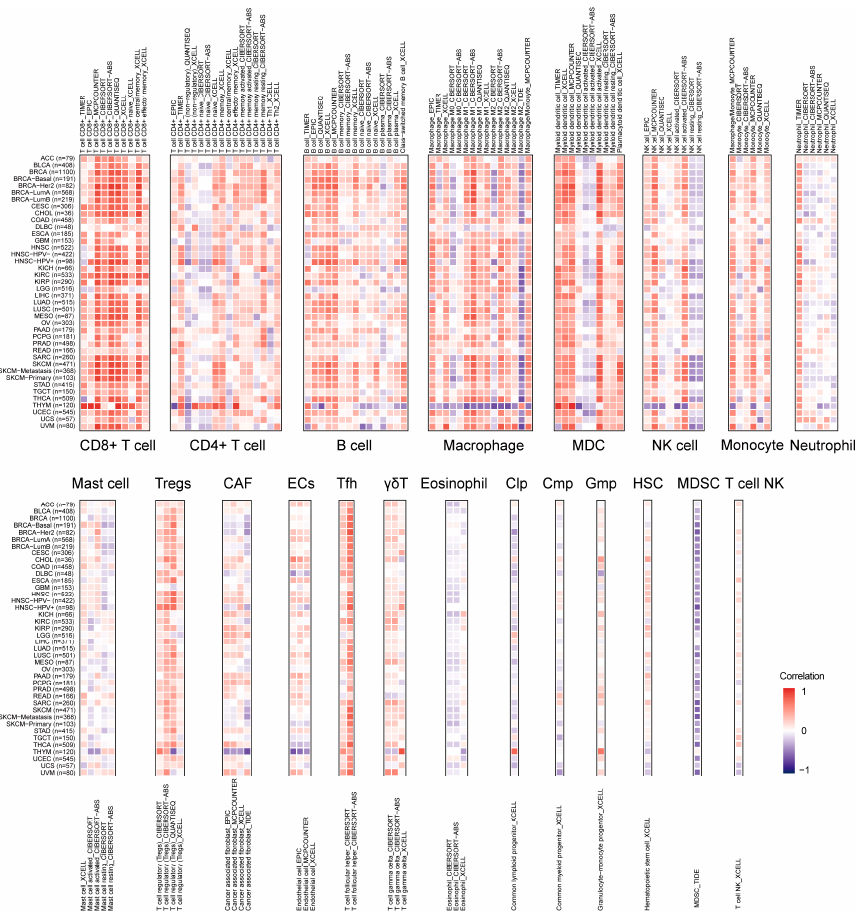
Figure 7. The correlations of LCK expression and immune infiltration across human cancers.